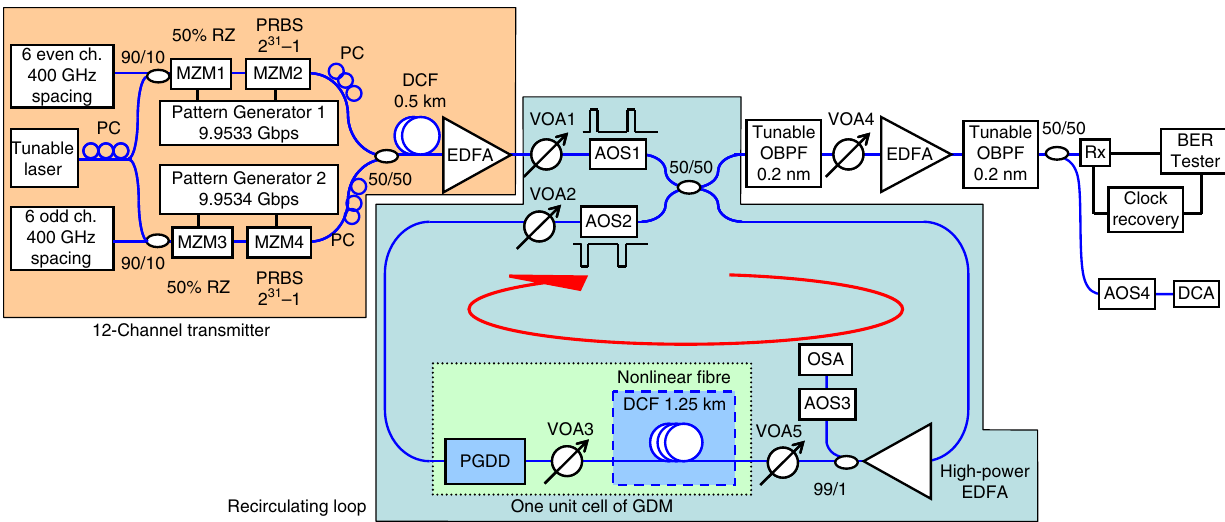
Fig. 2 Experimental recirculating-loop setup. 10-Gbps-modulated signals from 12-channel transmitter enter the recirculating loop containing one GDM unit cell. After fi ve circulations the signals are fi ltered and detected by a pre-ampli fi ed receiver (Rx). The tunable laser is used to generate ± 25% amplitude jitter when it is tuned to the wavelength of the signal channel to be measured. MZM: electro-optic Mach – Zehnder modulator, EDFA: erbium-doped fi bre ampli fi er, PC: polarisation controller, AOS: acousto-optic switch, VOA: variable optical attenuator, DCF: dispersion-compensating fi bre, OSA: optical spectrum analyser, OBPF: optical bandpass fi lter, DCA: digital communication analyser